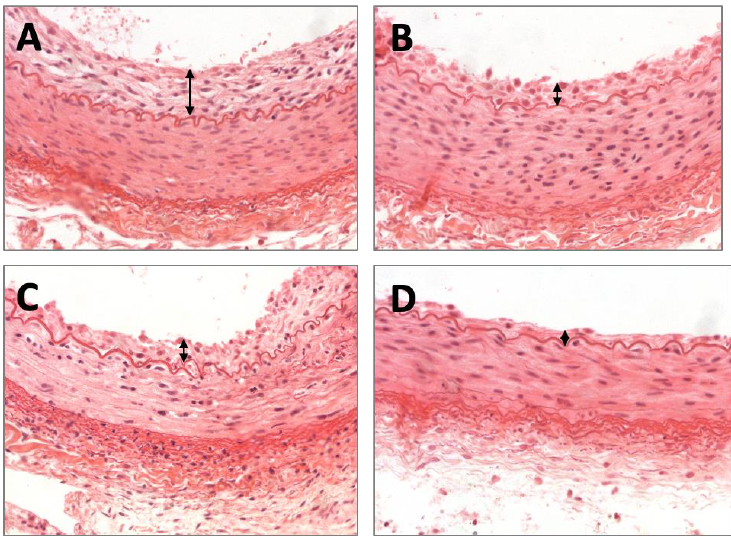
Figure 3. Representative images of the arterial response following the varying treatment groups. H&E staining demonstrated neointimal growth for ( A ) the uncoated balloon group, ( B ) keratose-only coated balloon, ( C ) paclitaxel-only coated balloon and ( D ) keratose – paclitaxel coated balloon at 7 coated balloon, ( C ) paclitaxel-only coated balloon and ( D ) keratose–paclitaxel coated balloon at 7 days. days. Neointimal growth is marked by double-arrow heads. Neointimal growth is marked by double-arrow